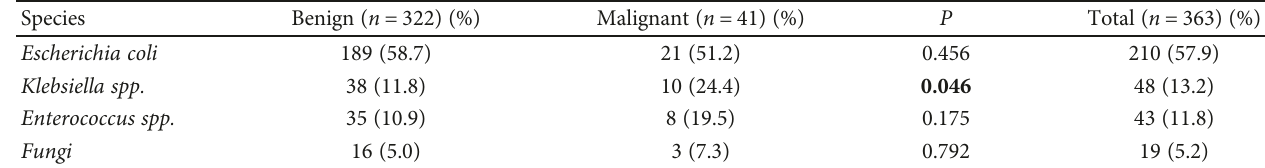
Table 3: Bacterial composition between benign and malignant